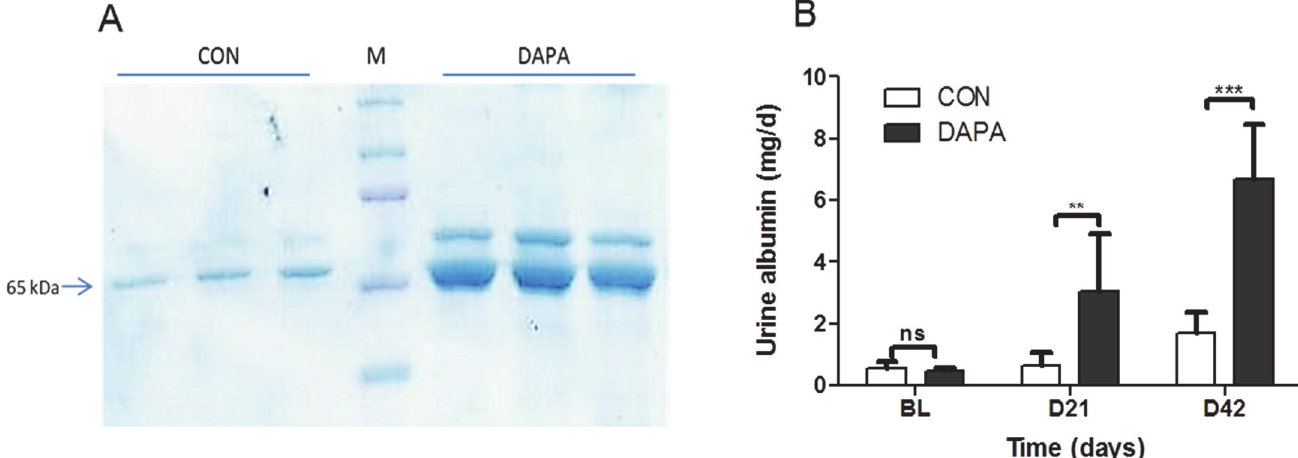
Fig 2. Effect of DAPA on albumin excretion. Urine protein analysis by SDS-PAGE from urine samples of PCK rats after 6 weeks of treatment with vehicle (CON) or dapagliflozin (DAPA). Each lane shows urine sample of a single PCK rat. Sample volumes were corrected for diuresis and amounted to 15 μ l for CON and 45 μ l for DAPA. Arrow shows the band for albumin. M = molecular weight marker (A). Urine albumin concentration as measured by ELISA, in mg/ day (B). N = 8 per group. Columns represent means ± SE. ** P < 0.01, *** P < 0.001 when comparing CON and DAPA at each time point, ns =